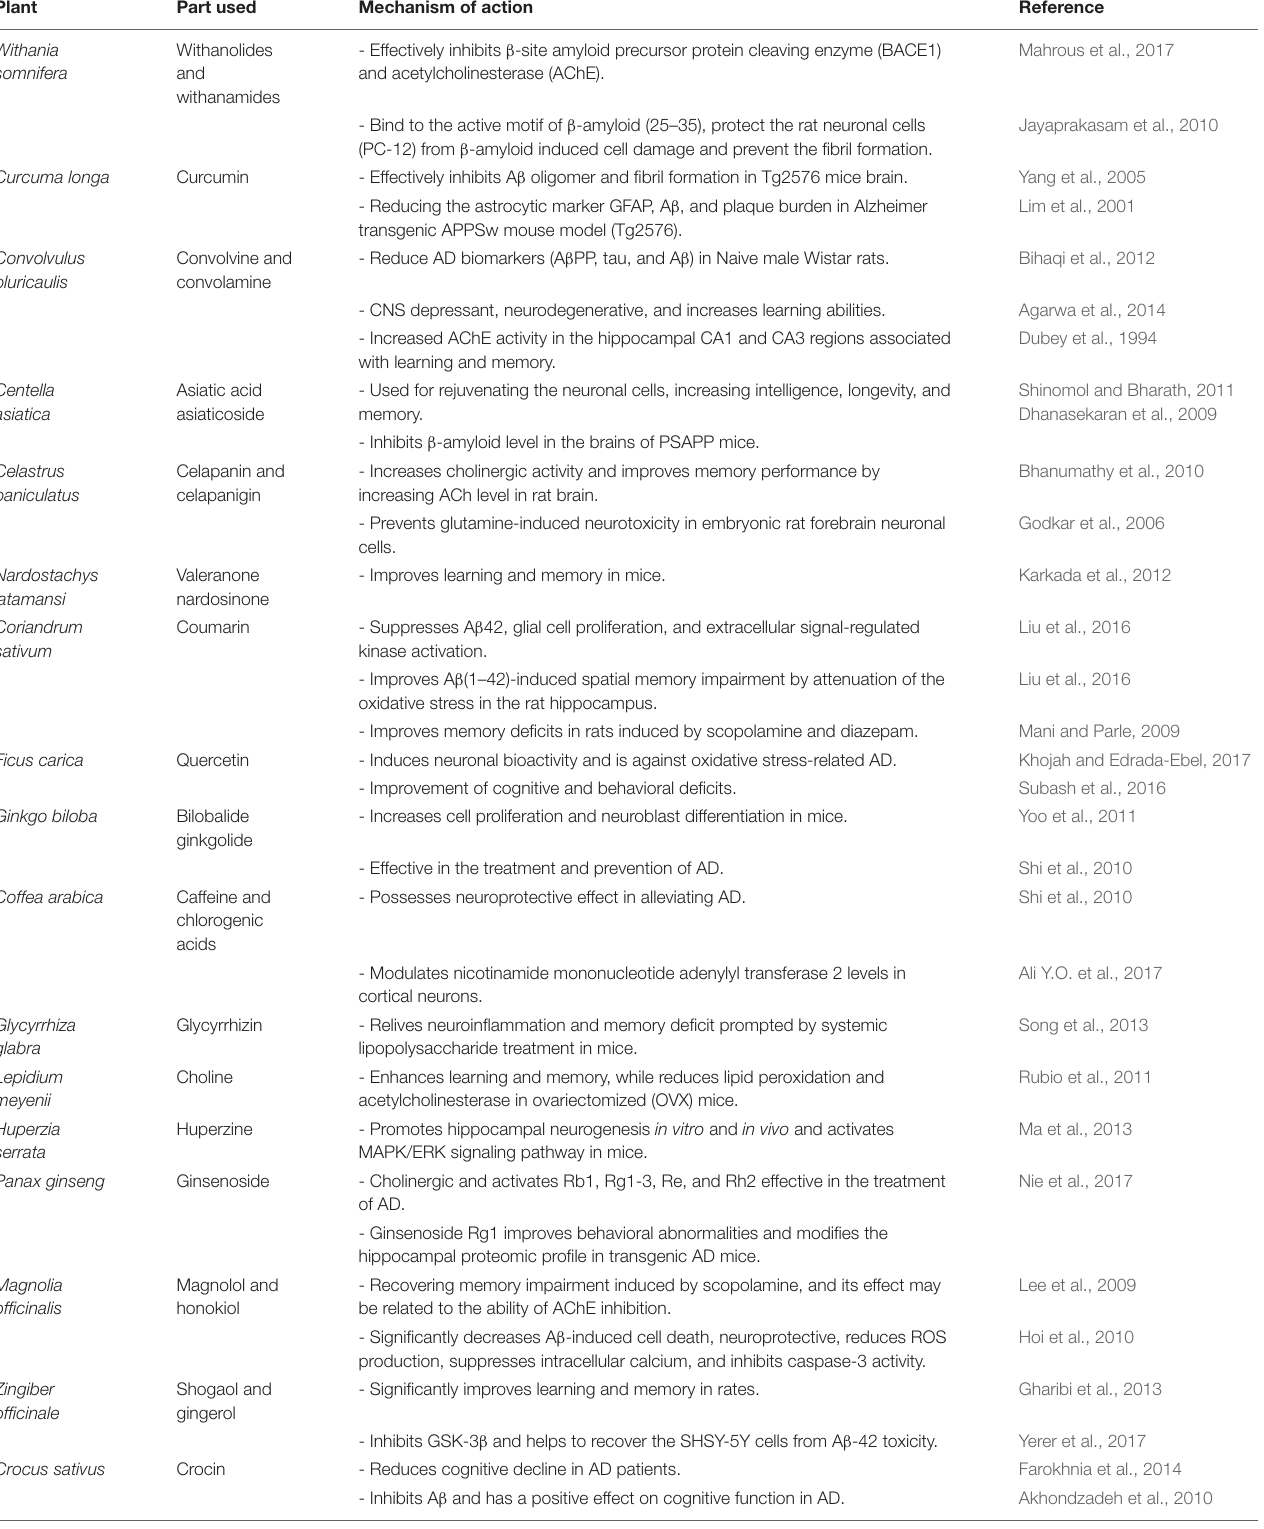
TABLE 1 | The major medicinal plants with potential bioactive compounds and their mechanisms of action against AD. Plant Part